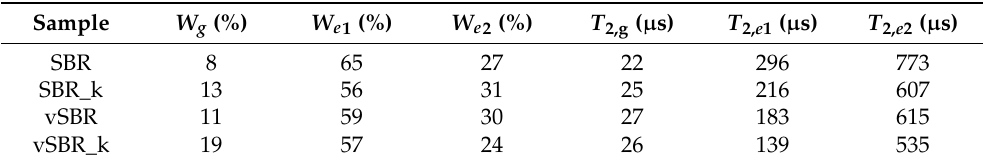
Figure 1. Expansion of the first 0.5 ms of the experimental 1 H FIDs of the investigated samples at 303 K. The inset shows the experimental curve (blue) and the total fitting function (magenta) obtained for vSBR, together with the single contributions of the Gaussian (cyan), intermediate- T 2 (orange), and long- T 2 (brown) exponential functions. Table 3. Weight percentages ( W i ) and T 2, i values obtained as best-fitting parameters from the analysis of the 1 H FIDs of the investigated samples through Equation (1).